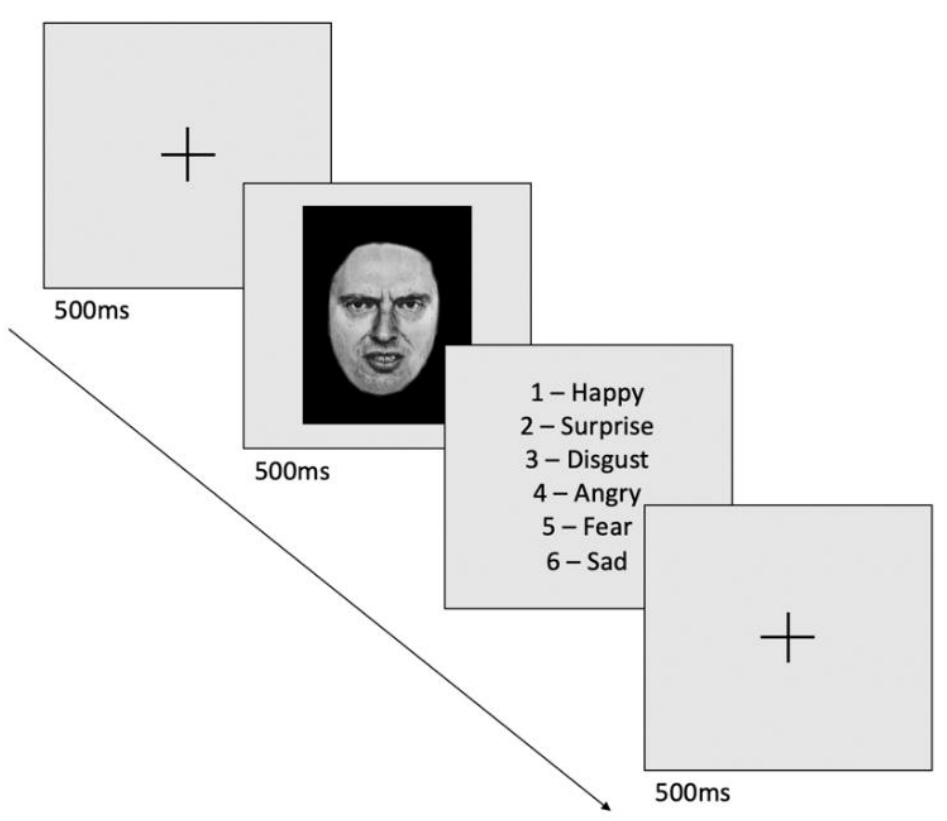
Figure 1. Illustration of the facial emotion recognition task. Faces expressing emotions at different intensities (happy, surprise, disgust, angry, fear or sad) were successively presented for 500 ms on a computer screen preceded by a fixation cross (500 ms).